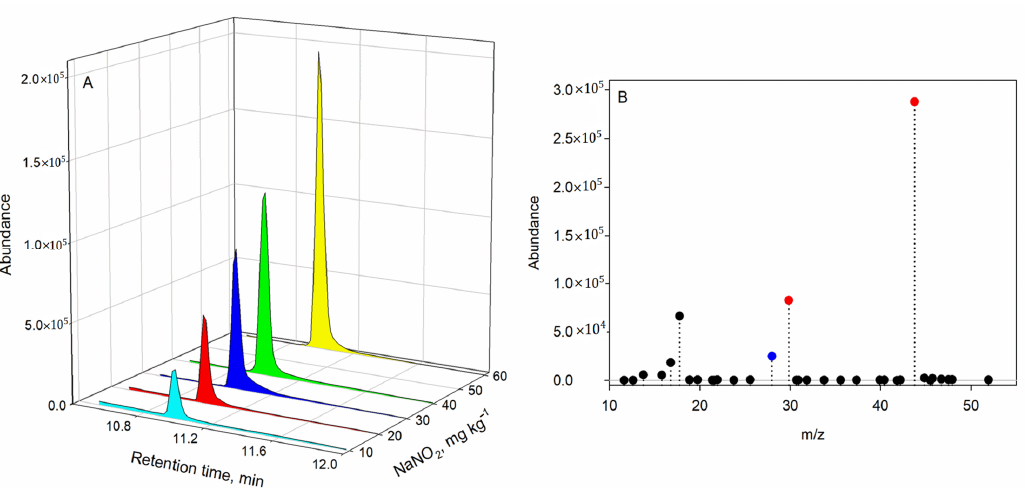
Figure 3. ( A ) Chromatographic profiles using headspace gas chromatography–mass spectrometry (HS-GC–MS) in selected ion monitoring (SIM) mode for different amounts of nitrite added to ham samples. ( B ) Mass fragmentation for nitrous oxide. Characteristic m / z values used were 43.8, 29.8, and 28.0.